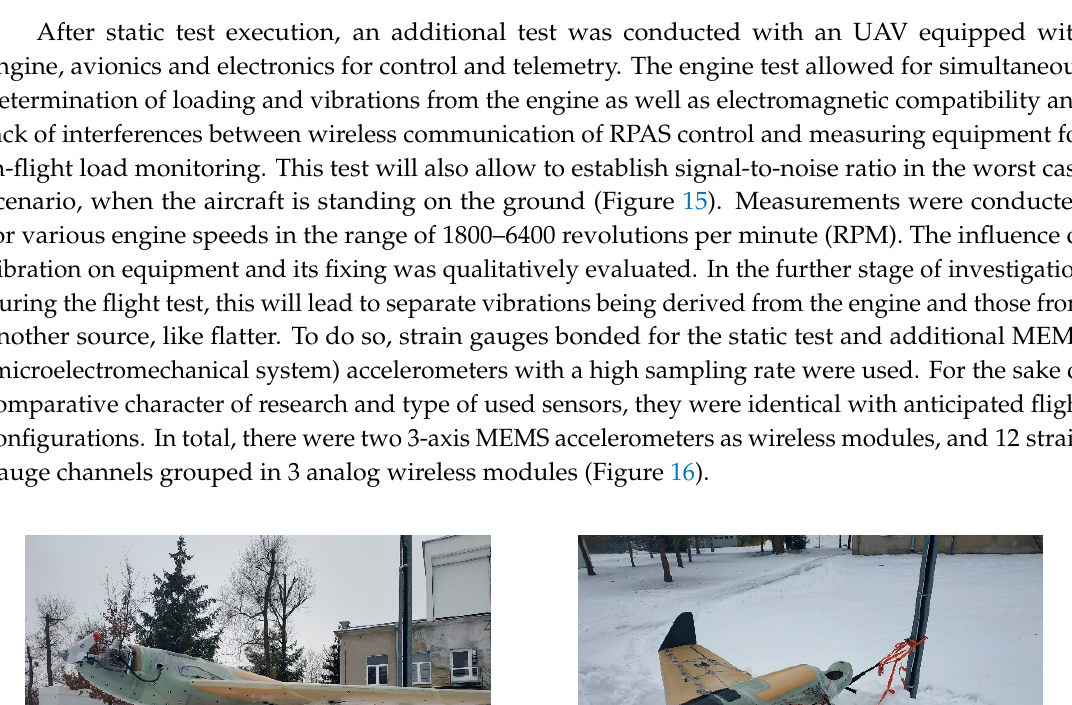
Figure 14. Structural deformation measurement with optical three-dimensional (3D) scanning system ( a ) camera ( b ) structure with reference point.